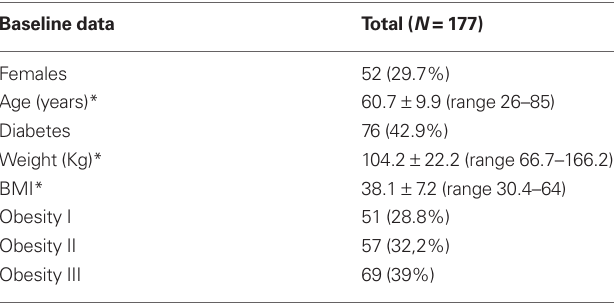
Table 1 | Demographic and medical characteristics.